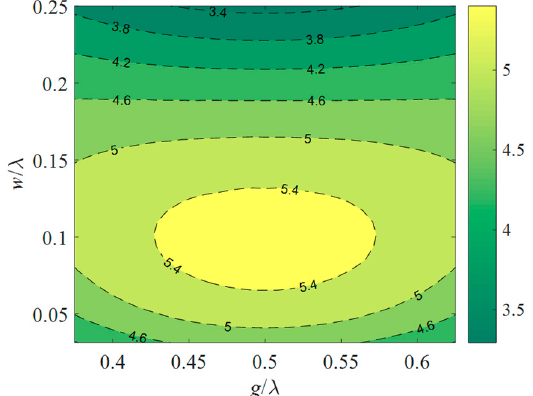
Figure 3. Reflectivity per period of Al electrodes on 128° YX LiNbO 3 substrate.